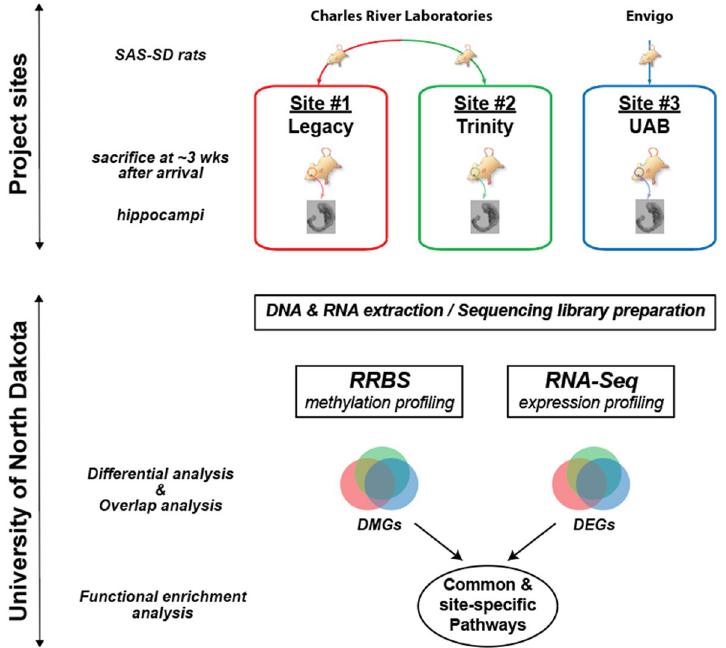
Figure 1. The overall workflow of the study. Animals were bred at three project sites: Site #1: Legacy Research, Site #2: Trinity College, and Site #3: the University of Alabama at Birmingham (UAB). Hippocampus was harvested from each animal and sent to the University of North Dakota for sequencing analysis. RRBS: reduced representation bisulfite sequencing. The workflow was created using Adobe Illustrator with the rat and hippocampus images obtained from http:// en. wikim edia. org under the Creative Commons Attribution- ShareAlike 3.0